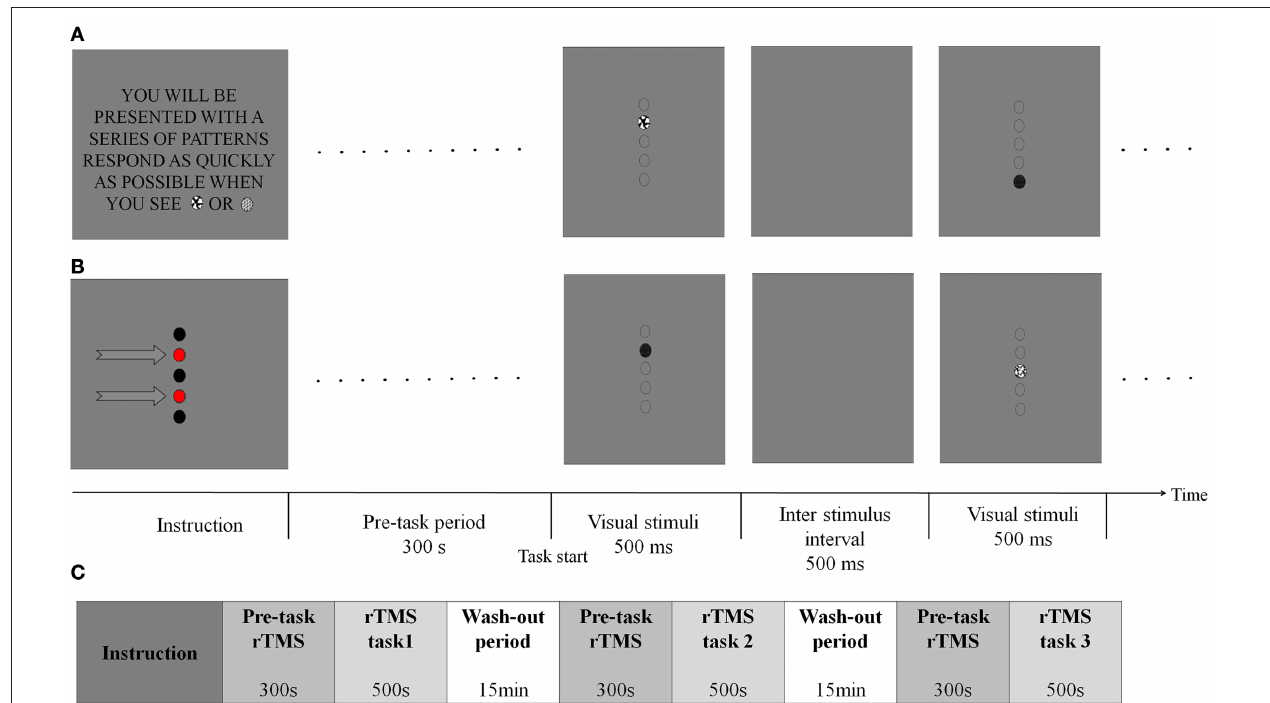
FIGURE 1 | Spatialandnon-spatialsustainedattentiontask design.(A) In thenon-spatialtask, subjectswereaskedto respondwhenevertheoneof two patternswaspresentedregardlessoftheirspatial location.Thetaskstarts after 300srTMS.Thefirstdisplayshowsatargetpatternandthethirddisplayshows anon-target.Broken-linecirclesindicatepotentialtargetweredisplayonablank screenandtherewerenotargetmarkers. (B) Inthespatialtask, subjectswere askedtorespondwheneverapatternwaspresentedat eitherofthetwo predefinedlocations(indicatedbyarrowsinthisfigure,butnotdisplayedduring theactualexperiment).Thefirsttestdisplayshowsapatternappearingatoneof